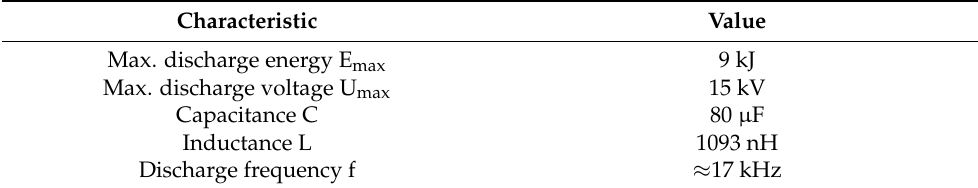
Table 2. Characteristics of capacitor bank SMU612.